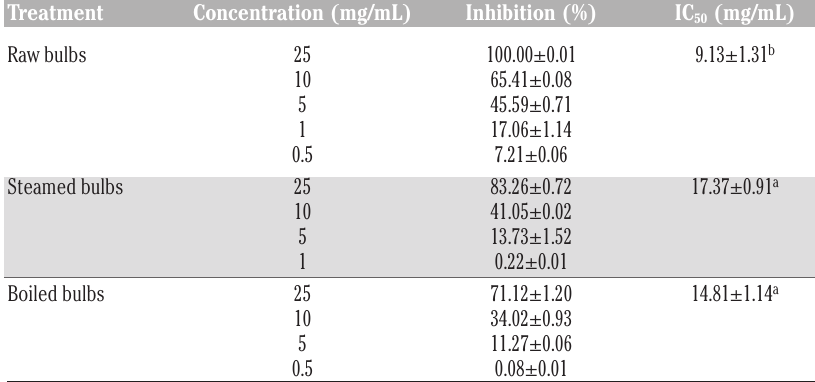
Table 2. Antioxidant activity evaluated by β -carotene bleaching method of extracts of raw and cooked lampascioni (Muscari